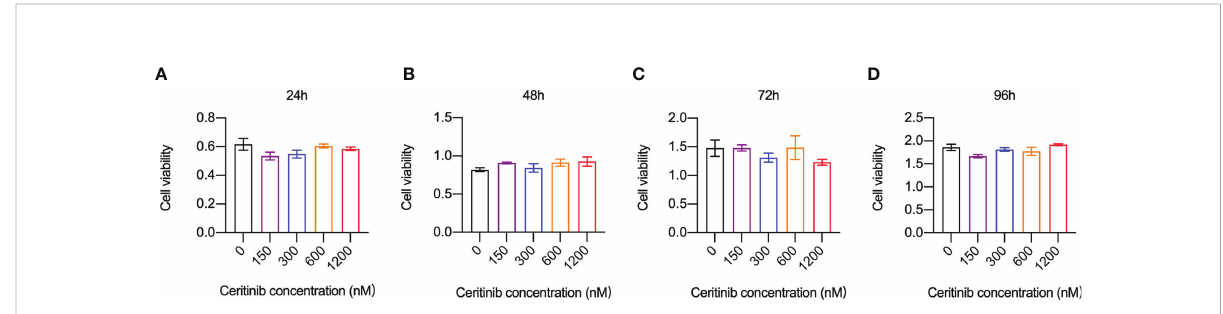
FIGURE 1 Ceritinib did not affect BMM-cell in vitro . Cell viability and proliferation capacities (absorbance) of BMMs remained stable when they were incubated with ceritinib (150, 300, 600, and 1200 nM) for 24 (A) , 48 (B) , 72 (C) , and 96 h (D)